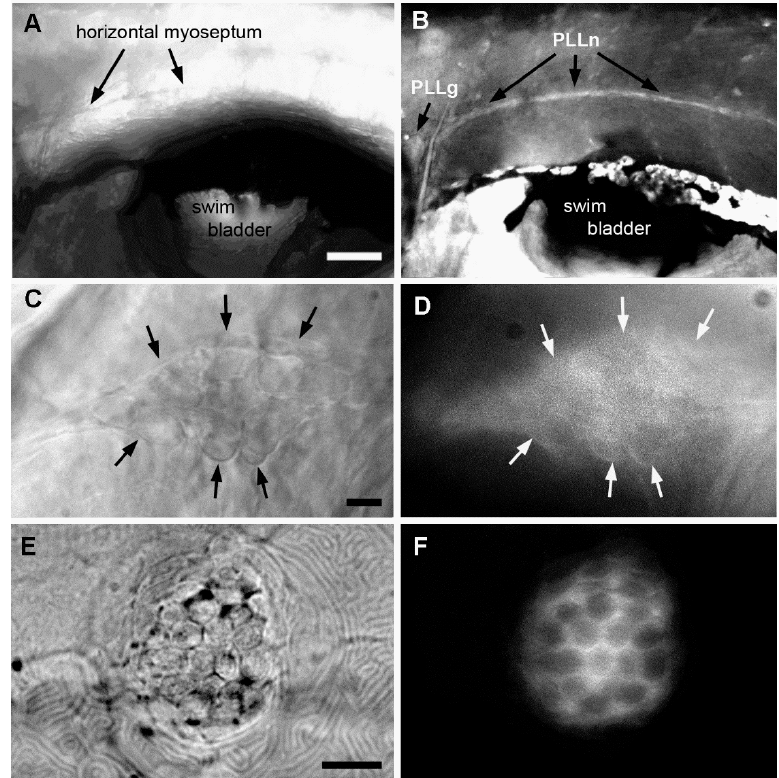
Figure 5. Accumulation of A6 in the lateral line system of embryos that had been incubated in 50 nM A6 from 1 to 6 dpf. ( A , B ) Anterior trunk region; ( C , D ) Lateral line ganglion; ( E , F ) Neuromast L2; ( A , C , E ) Bright field; ( B , D , F ) Fluorescence. Arrows in ( C , D ) outline the PLL ganglion. Scale bars: ( A ) 100 μ m, ( C , E ) 10 μ m.